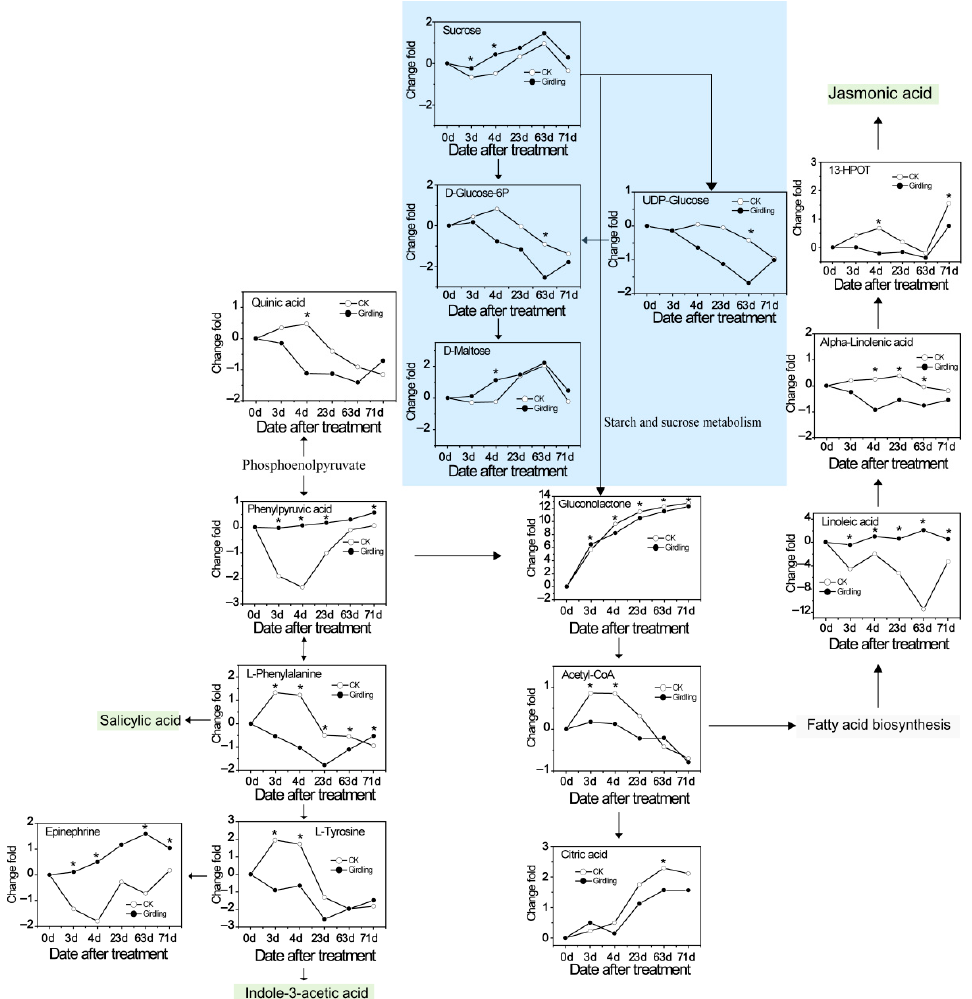
Figure 6. Changes of metabolite concerning flowering in metabolic pathways in Guiwei litchi leaves of terminal flush. CK indicates samples of trees from the control group. Girdling indicates samples of trees from the girdled group. The numbers 0, 3, 4, 23, 63, and 71 indicate the sampling time. Values represent means of log 2 -transformed fold-changes from the six biological replicates relative to 0 day. Asterisks and five-pointed stars indicate significant differences between the girdled and control groups determined by an unpaired t -test at p < 0.05. White dots represent samples of trees from the control group. Black dots represent samples of trees from the girdled group.